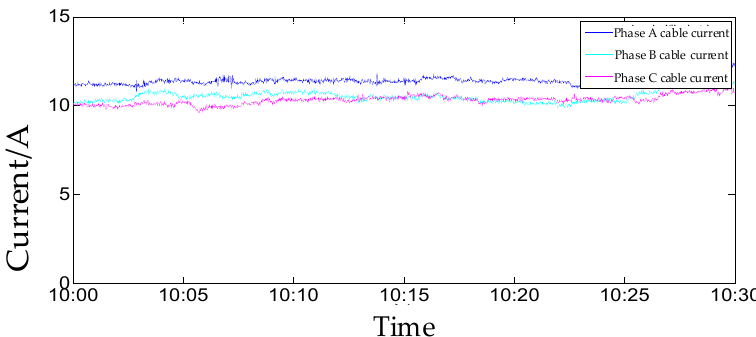
Figure 10. “Hukun 1” 10 kV cable power transmission line through the cable core current.